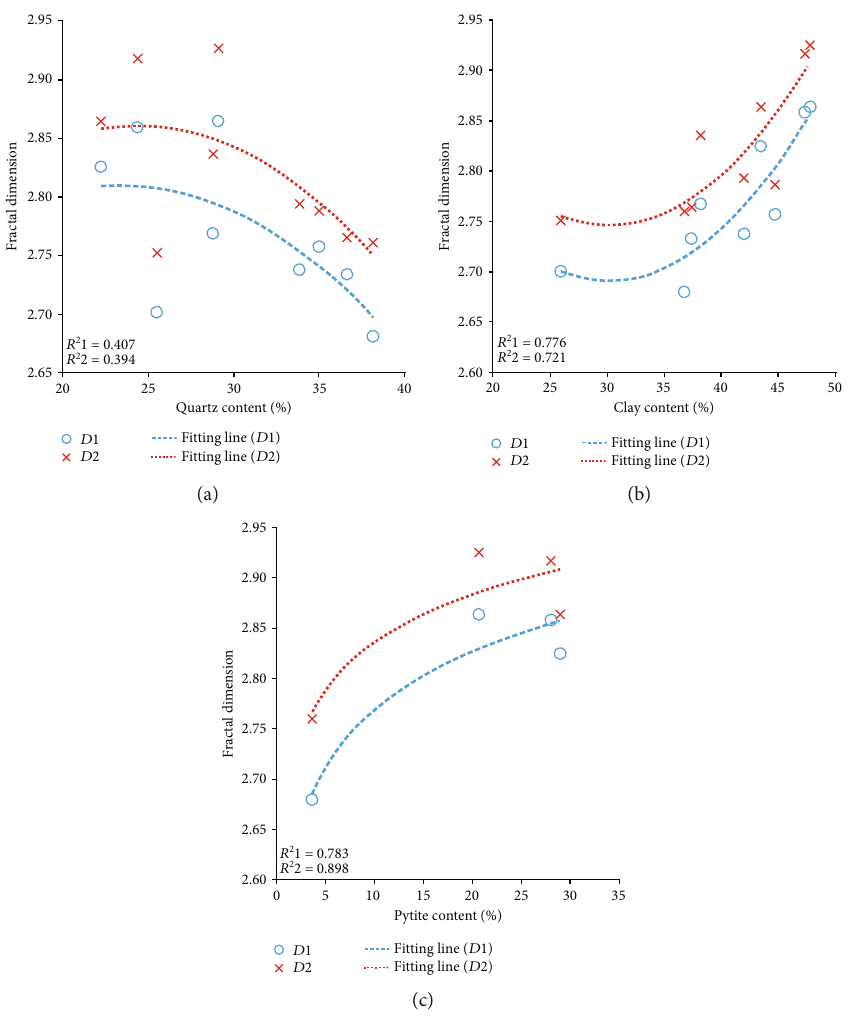
Figure 9: Correlation between fractal dimensions and mineral content of Longtan